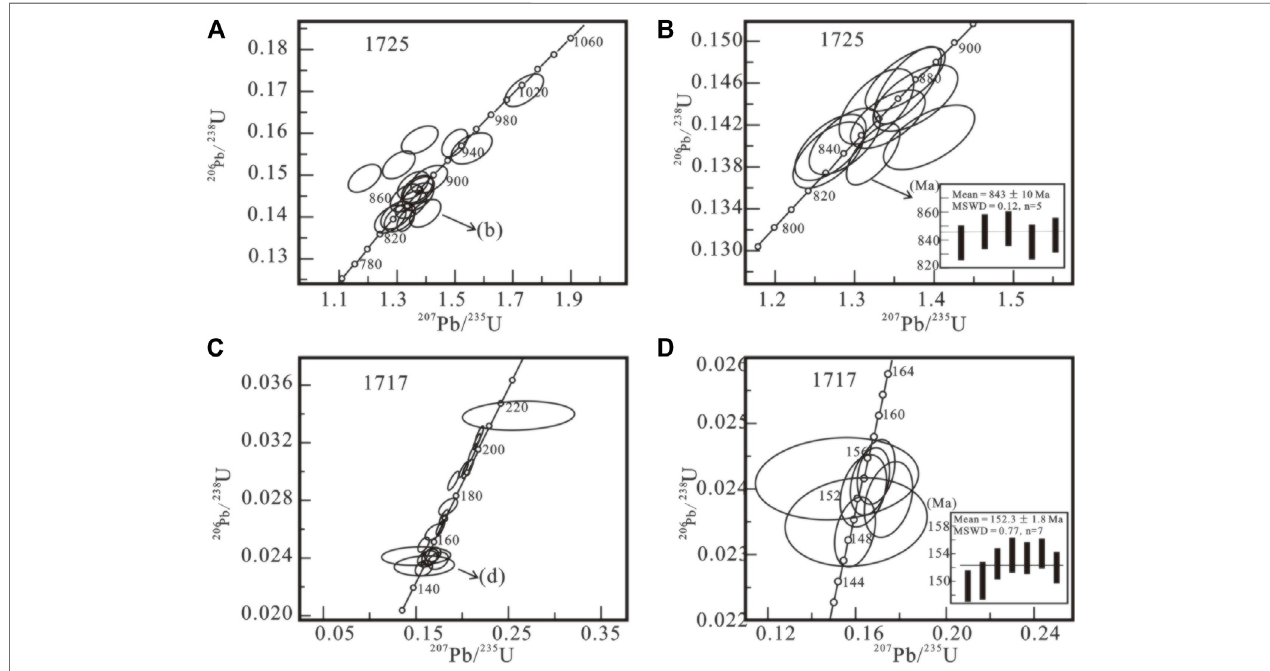
FIGURE 5 | SHRIMP Zircon U-Pb concordia diagram of the granite dyke (Sample 1725) (A,B) and the granitic porphyry dyke (Sample 1717) (C,D) .